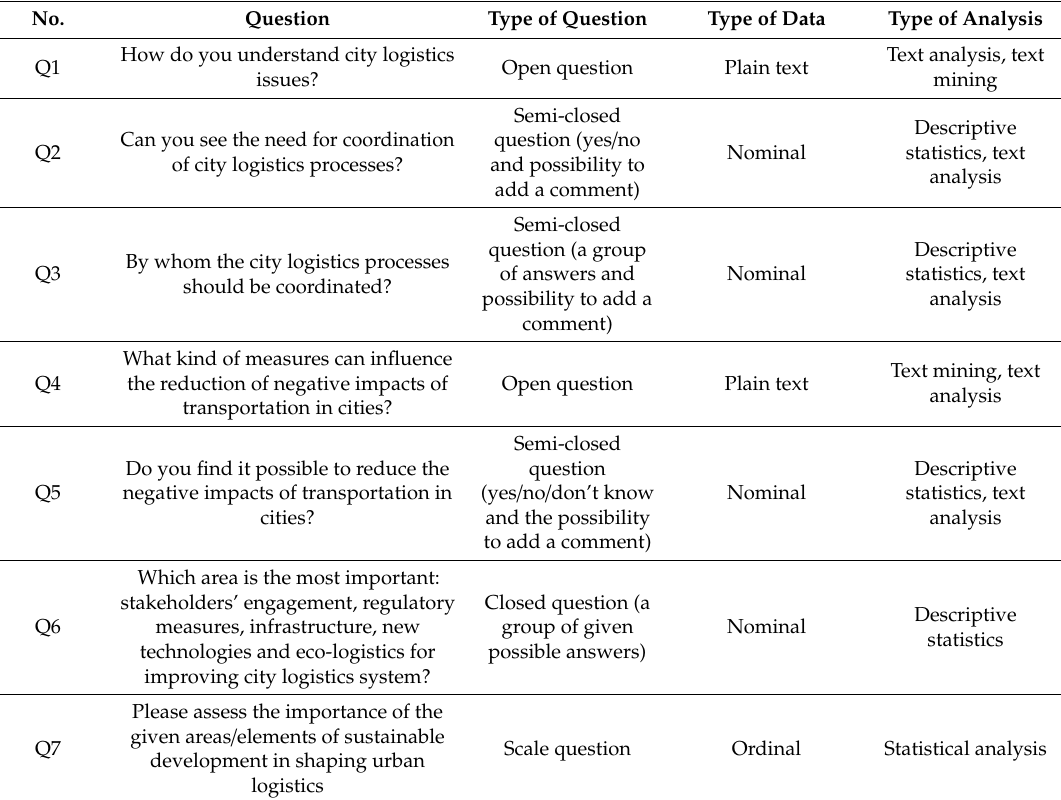
Table 3. Interview